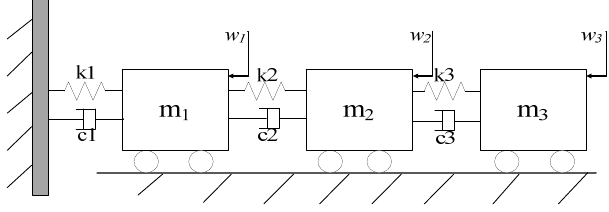
Figure 1. Model of the three degrees of freedom (DOFs) system.